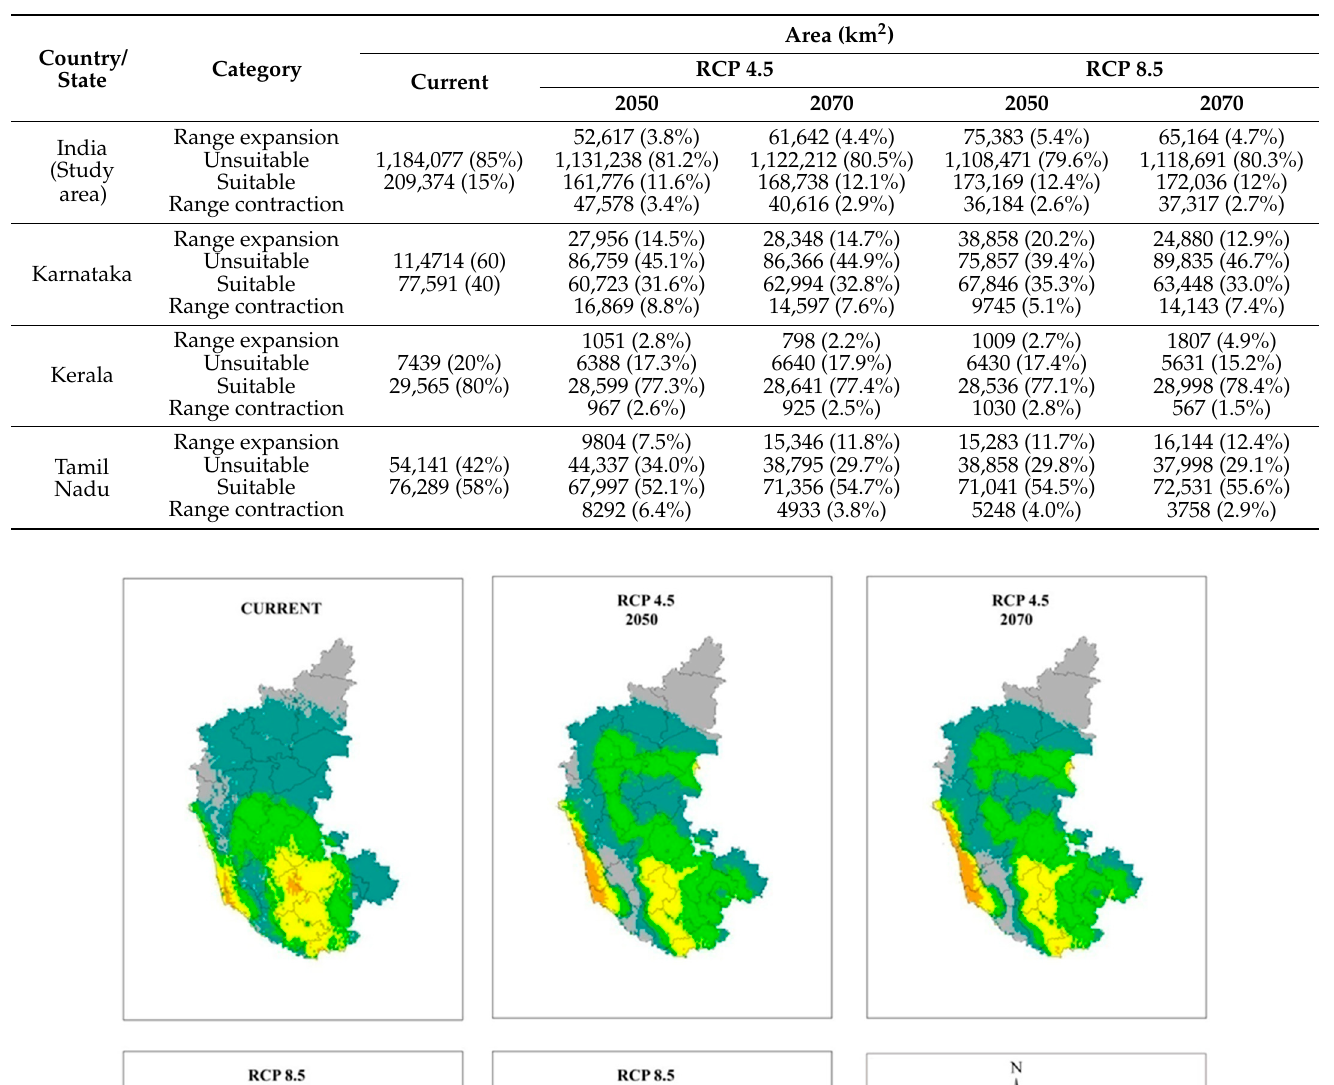
Table 6. Climatically suitable and unsuitable areas for growing coconut under the current and the future climate of RCP 4.5 and RCP 8.5 and the range expansion and contraction (the values in brackets are the difference in percentage from total study area) as modeled by MaxEnt for India and major coconut growing states.